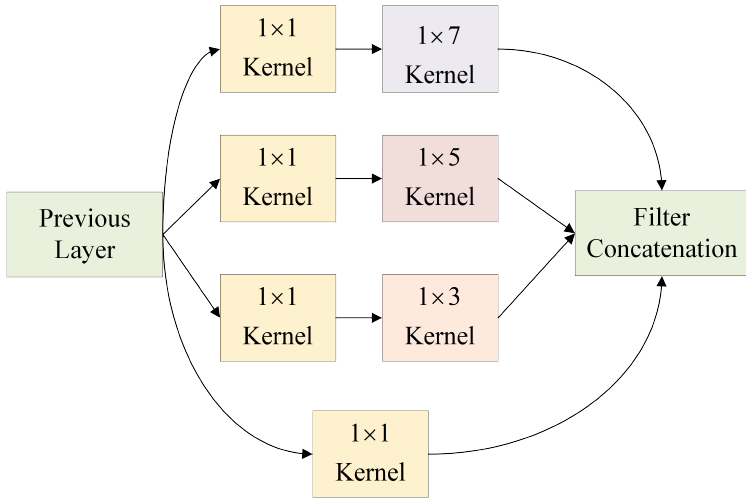
Figure 3. The structure of Inception block used in this